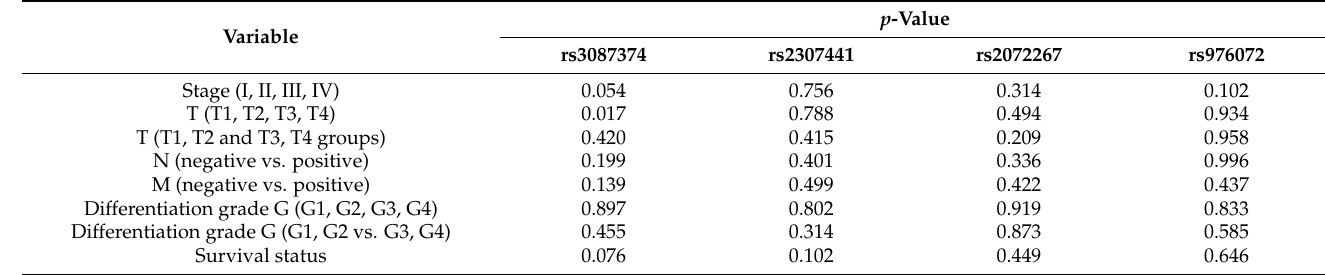
Table 5. POLG gene genotype associations with disease and tumor